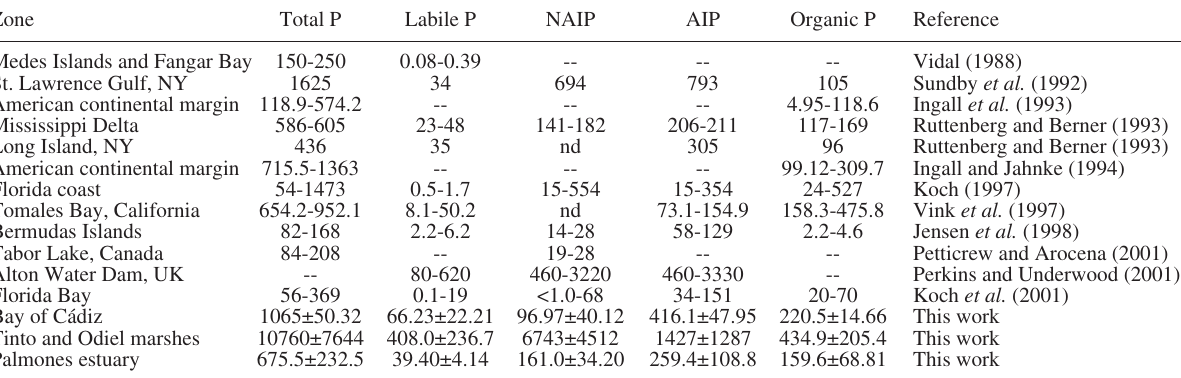
Table 6. – Values of phosphorus fractions (in µg P g.sed -1 ) found by other authors and in sediment in the zones studied.